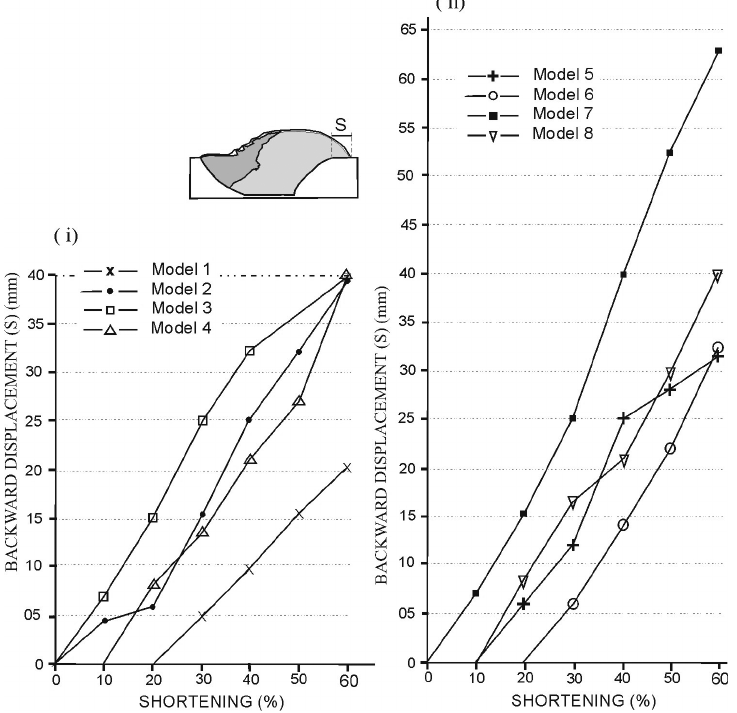
Fig. 7 – Plots of backward displacement on backstop flat (S) (see inset cross-section) vs. shortening (%) for the inversion experiments with (i) a convex-up mobile backstop (models 1 to 4) and (ii) a concave-up mobile backstop (models 5 to 8). The concave-up mobile backstop model 7 produces the highest backward displacement due to its high normal detachment cut-off angle and its low backstop cut-off angle.